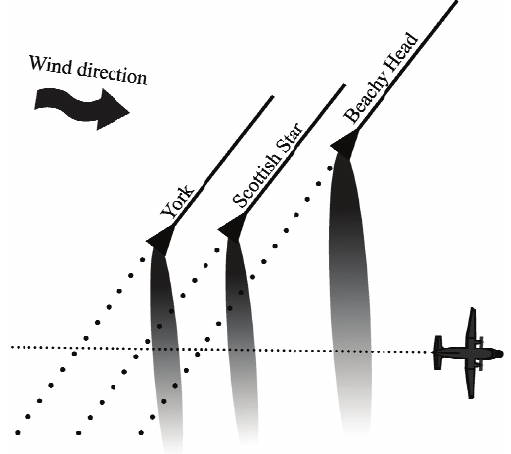
Fig. 3. An illustration of a flight transect across emission plumes from the ships Jork, Scottish Star and Beachy Head. The ships were travelling northwards in the Baltic Sea, outside the island of Got- land. The measurement was carried out from a CASA-212, an air- plane operated by the Swedish coastguard on 24 August 2009. The corresponding raw data of NO 2 is shown in Fig. 6.